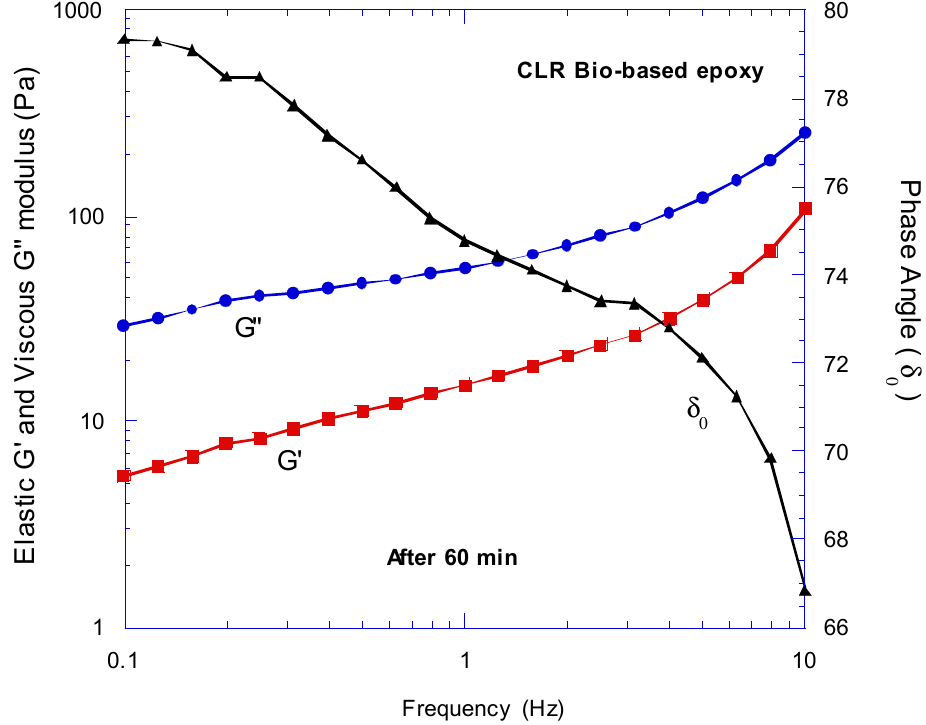
Figure 8. Frequency sweep result of CLR epoxy 60 min after the mixing of the hardener.